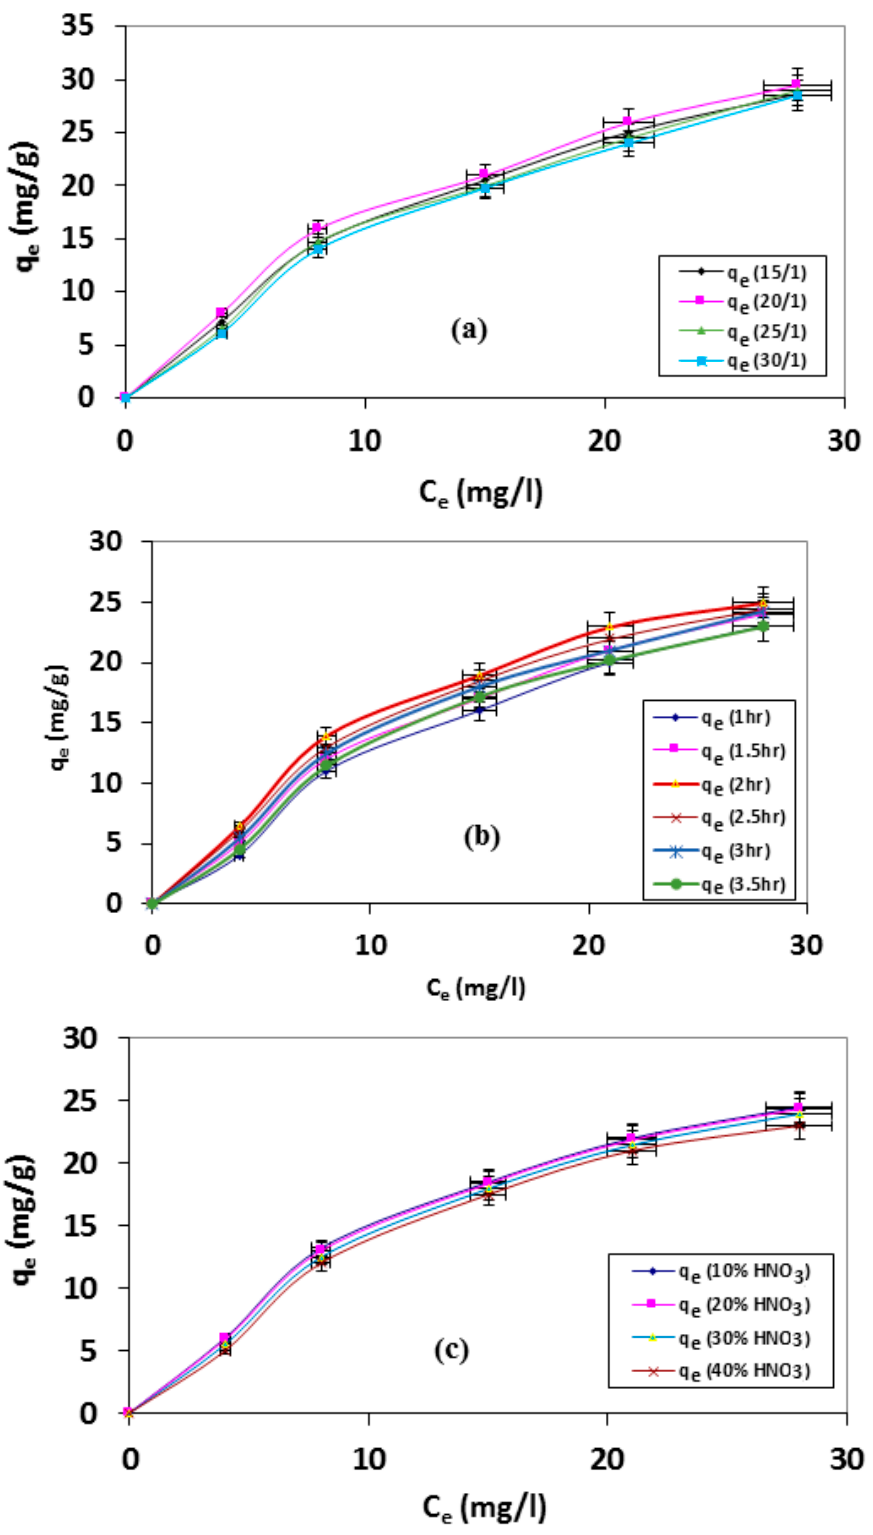
Figure 4. Adsorption isotherms of MB at 25 ± 2 °C onto nitric acid treated AC at different ( a ) nitric acid/AC ratios; ( b ) oxidation times; and ( c ) nitric acid concentrations (oxidation time = 2 h, nitric acid concentration = 30%, nitric acid/AC ratio = 20/1).